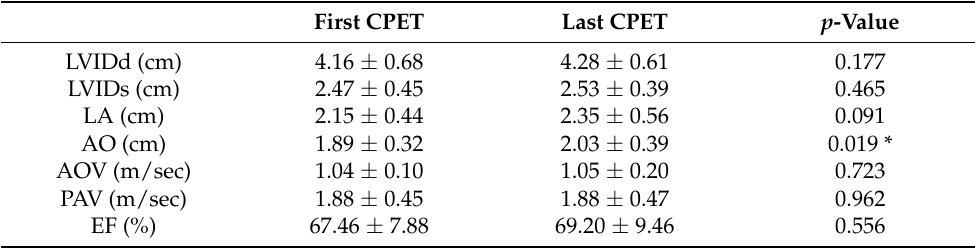
Table 5. Corresponding transthoracic echocardiographic findings of the first and last cardiopul- monary exercise testing in participants with pulmonary valve